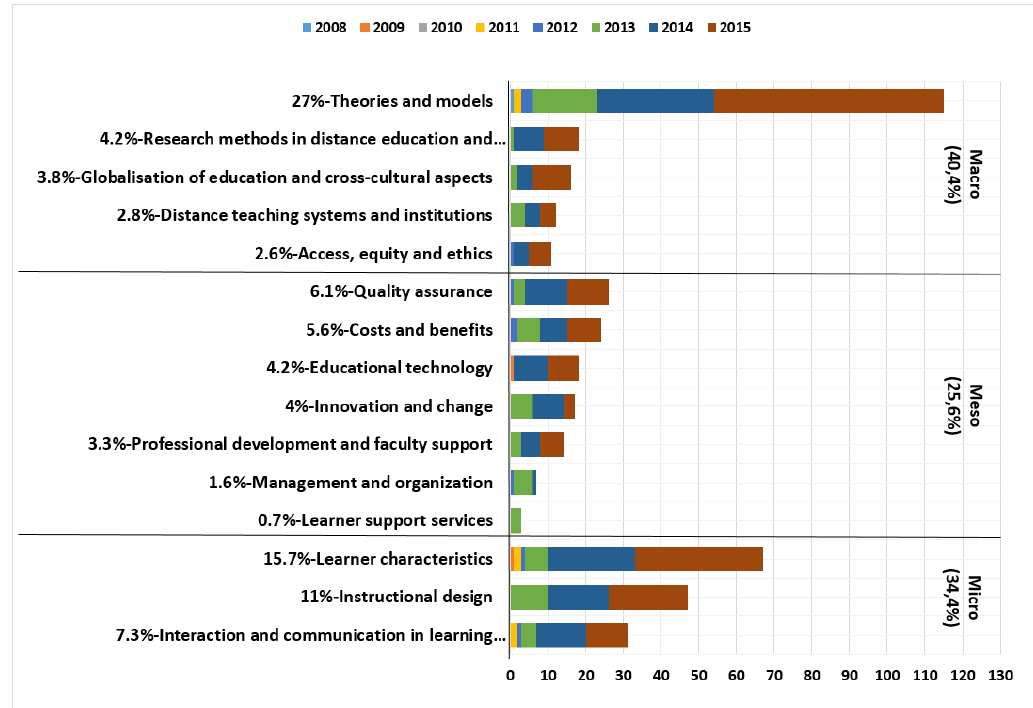
Figure 3. Distribution of research areas by